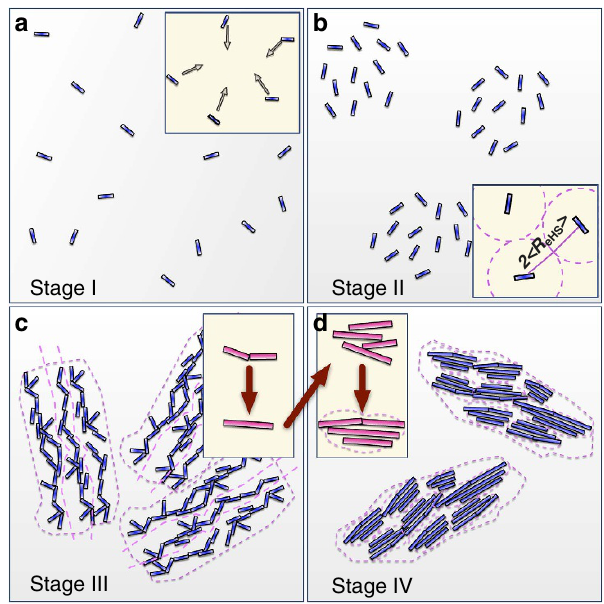
Figure 5 | Schematic representation of the four stages of CaSO 4 formation. ( a , b ) As observed for our experimental conditions: (stage I) formation of well-defined, sub-3nm primary species/scatterers; (stage II) formation of domains of primary species; inset shows that scatterers are on average separated by a distance of 2 o R eHS 4 ; (stage III) aggregation and self-assembly of the primary species forming large surface fractal morphologies; (stage IV) growth and coalescence of the primary species within the aggregates; insets in c and d show the consequent stages of growth—increase in length followed by increase in all dimensions eventually leading to larger